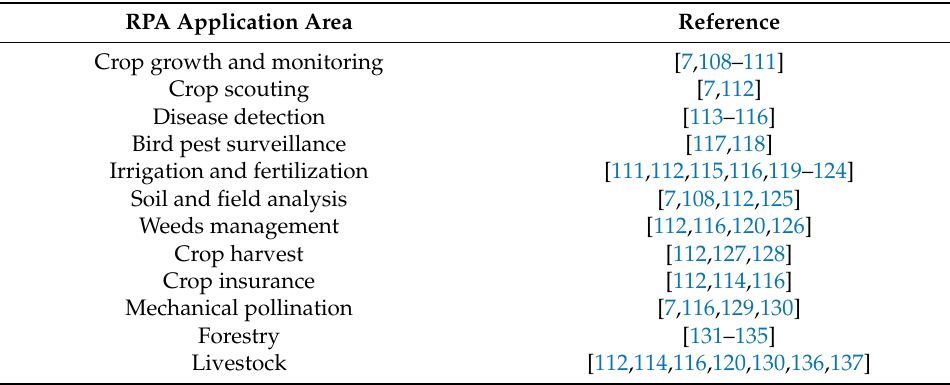
Figure 7. A set of field zones recommended for treatment based on the vegetation indices (VIs) maps, generated using a parrot sequoia and Yuneec CGOET mounted on a Yuneec Typhoon H hexacopter RPA for olive crops (image facilitated by MCBiodrone). Table 2. A summary of a few representative studies for principal agricultural applications of RPAs. (The purpose of citing these references is impartial and is not confined to these studies